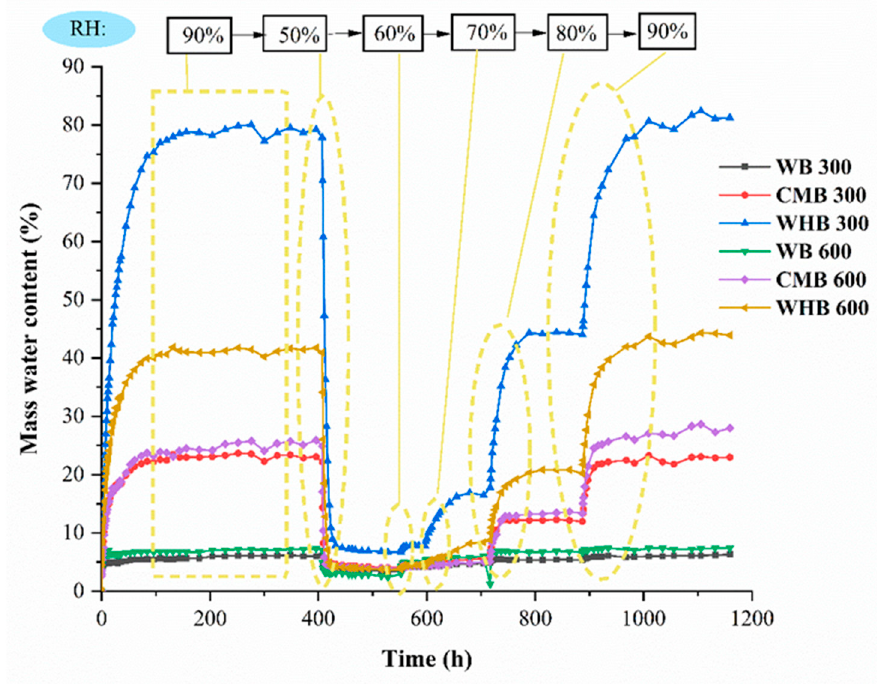
Figure 6. Water absorption behavior of different biochars with time at different relative humidity conditions under 30 °C temperature conditions.